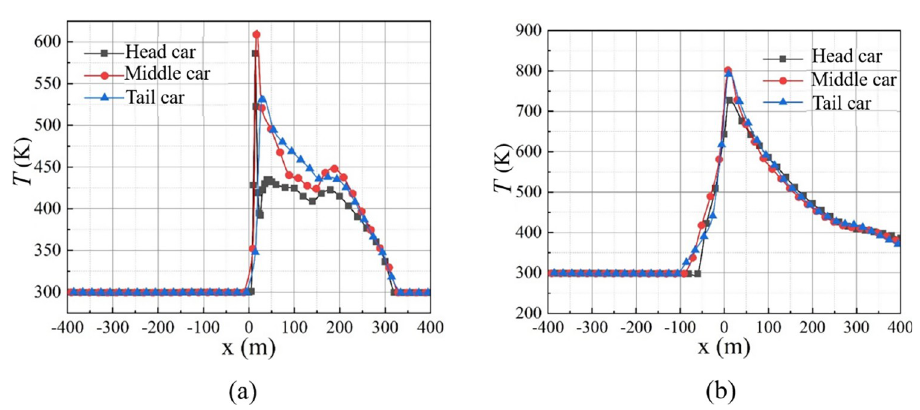
Fig 13. Distribution of temperature for different fire locations. (a) t = 100 s; (b) t = 250 s.